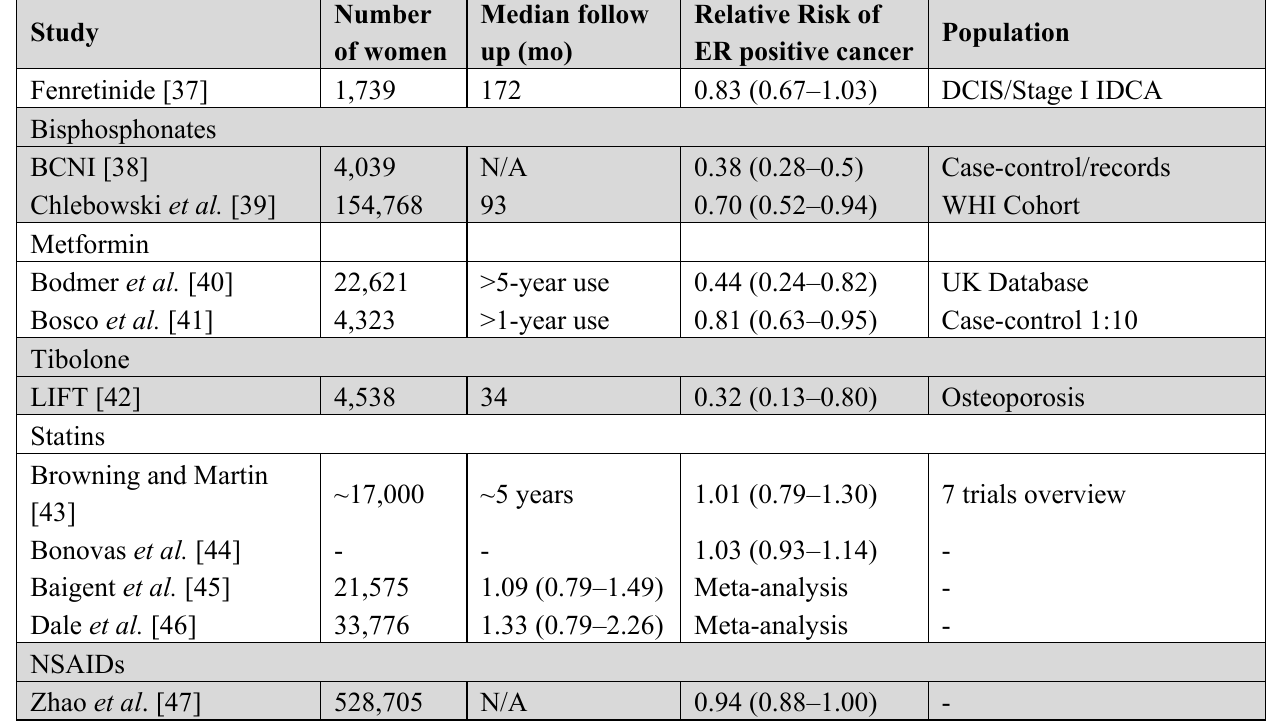
Table 5. Studies on non-endocrine agents as a breast cancer preventive